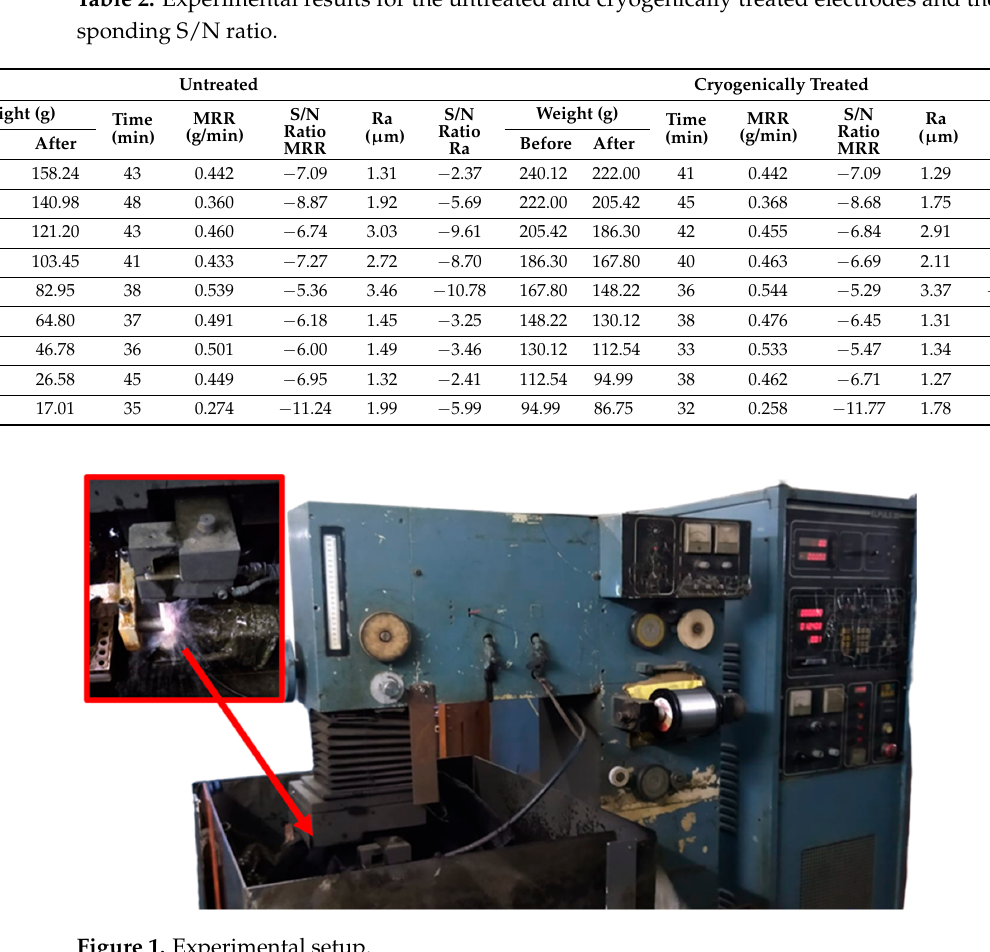
Figure 1. Experimental setup.